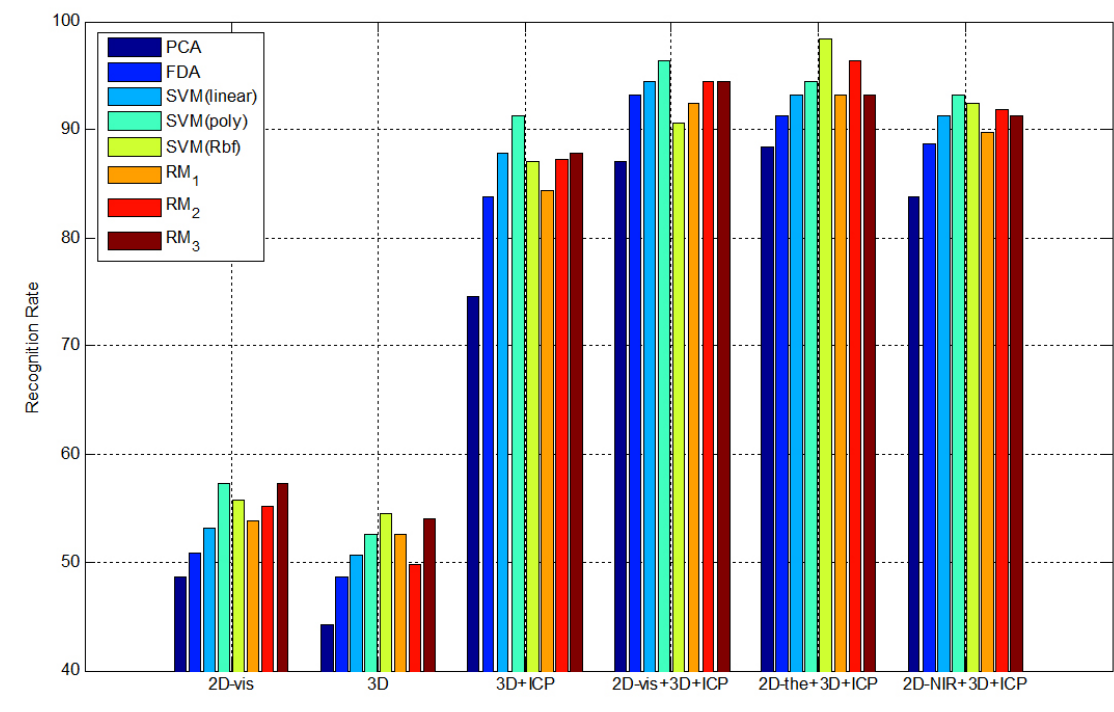
Figure 20. Recognition rate in terms of recognition